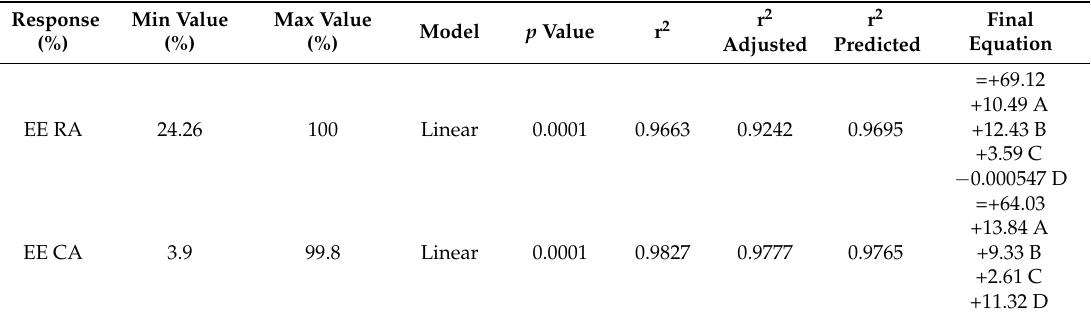
Table 2. The fitting models, equations, and statistical parameters of the experimental